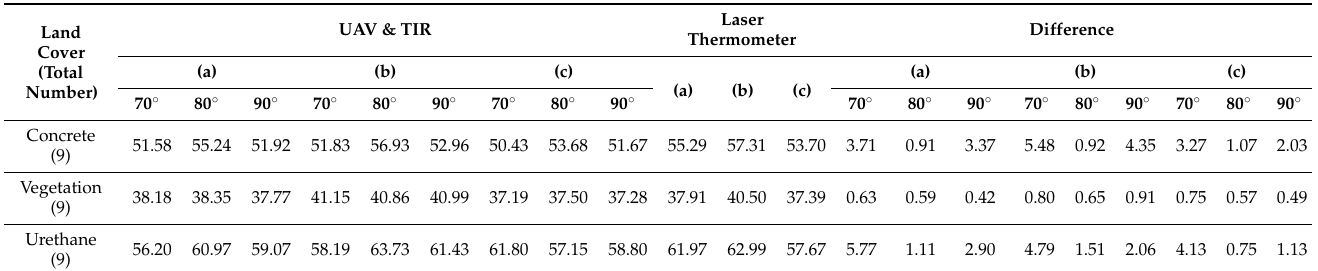
Table 6. Average LST difference of site B by land cover (unit: ◦ C): ( a ) 30 July 2021, ( b ) 6 August 2021, ( c ) 18 August 2021.